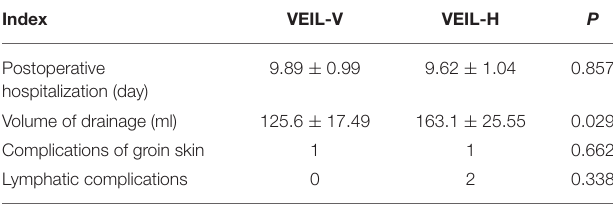
TABLE 3 | Comparison of postoperative recent